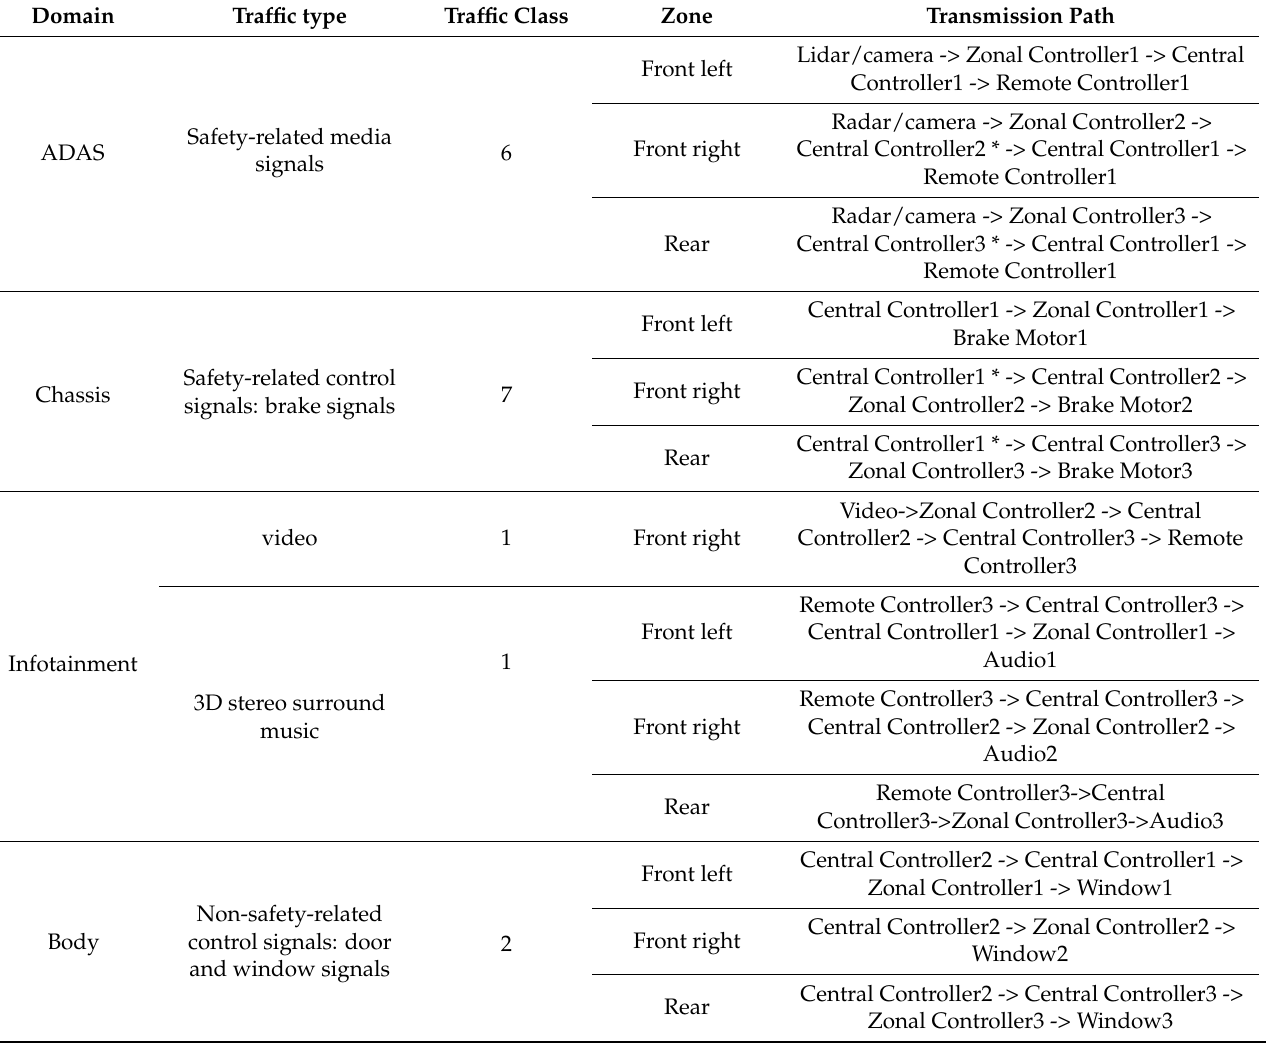
Table 5. Design table of traffic priority and